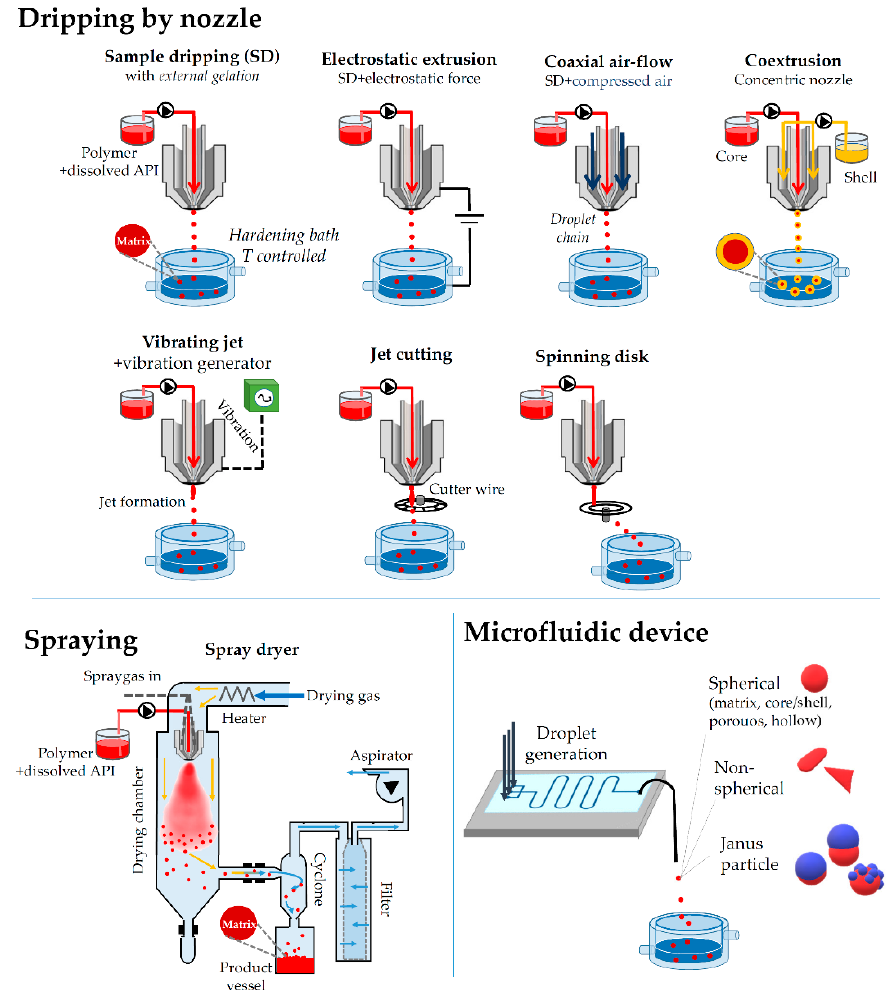
Figure 5. Preparation processes through droplet formation at an orifice.